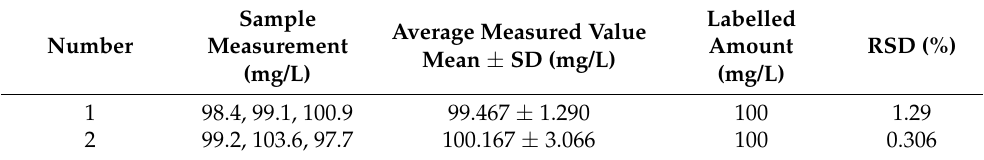
Table 4. Determination of samples and comparison with the labelled amount.